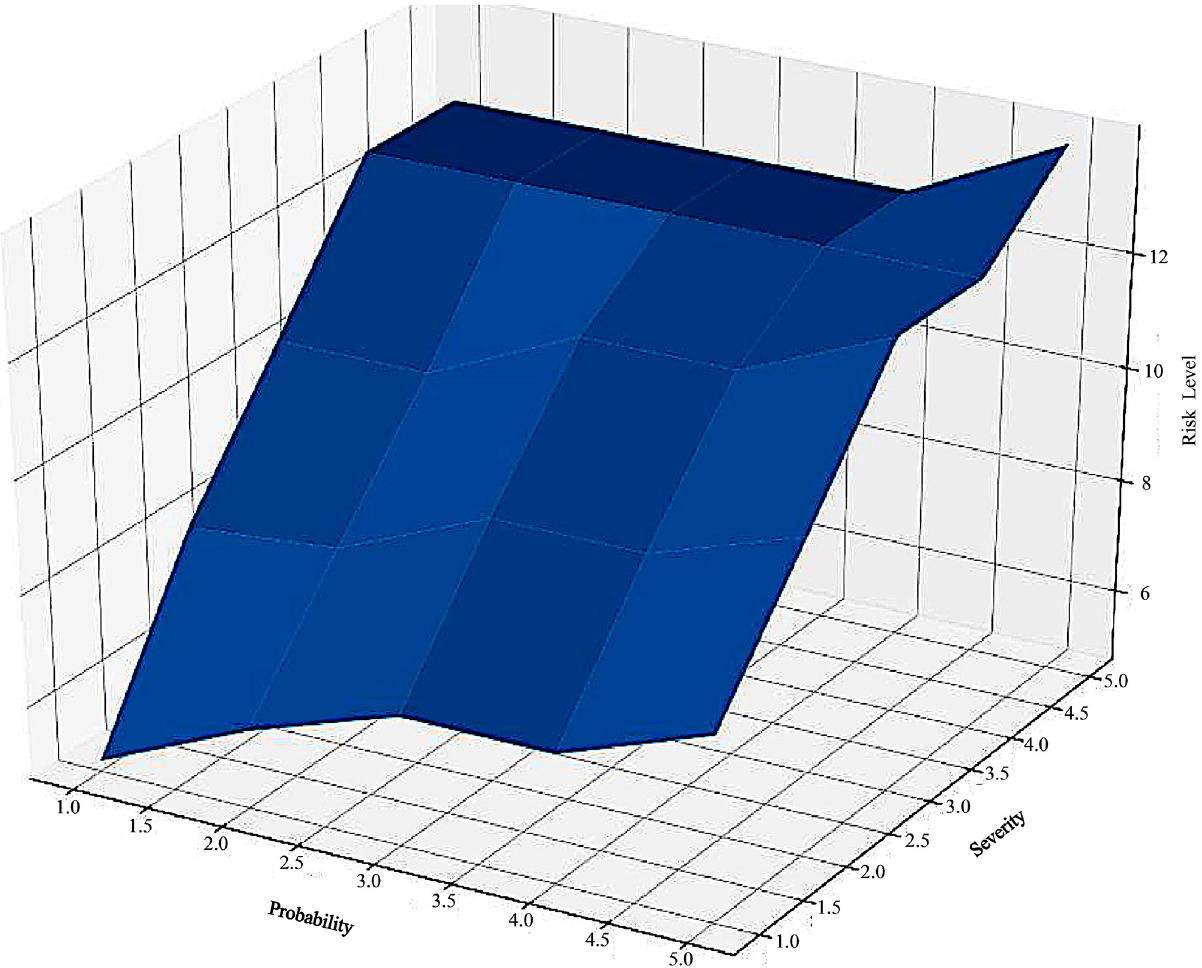
Fig 6. The 3D surface plot of the output variable: Risk level, versus the two input variables: Probability and severity.